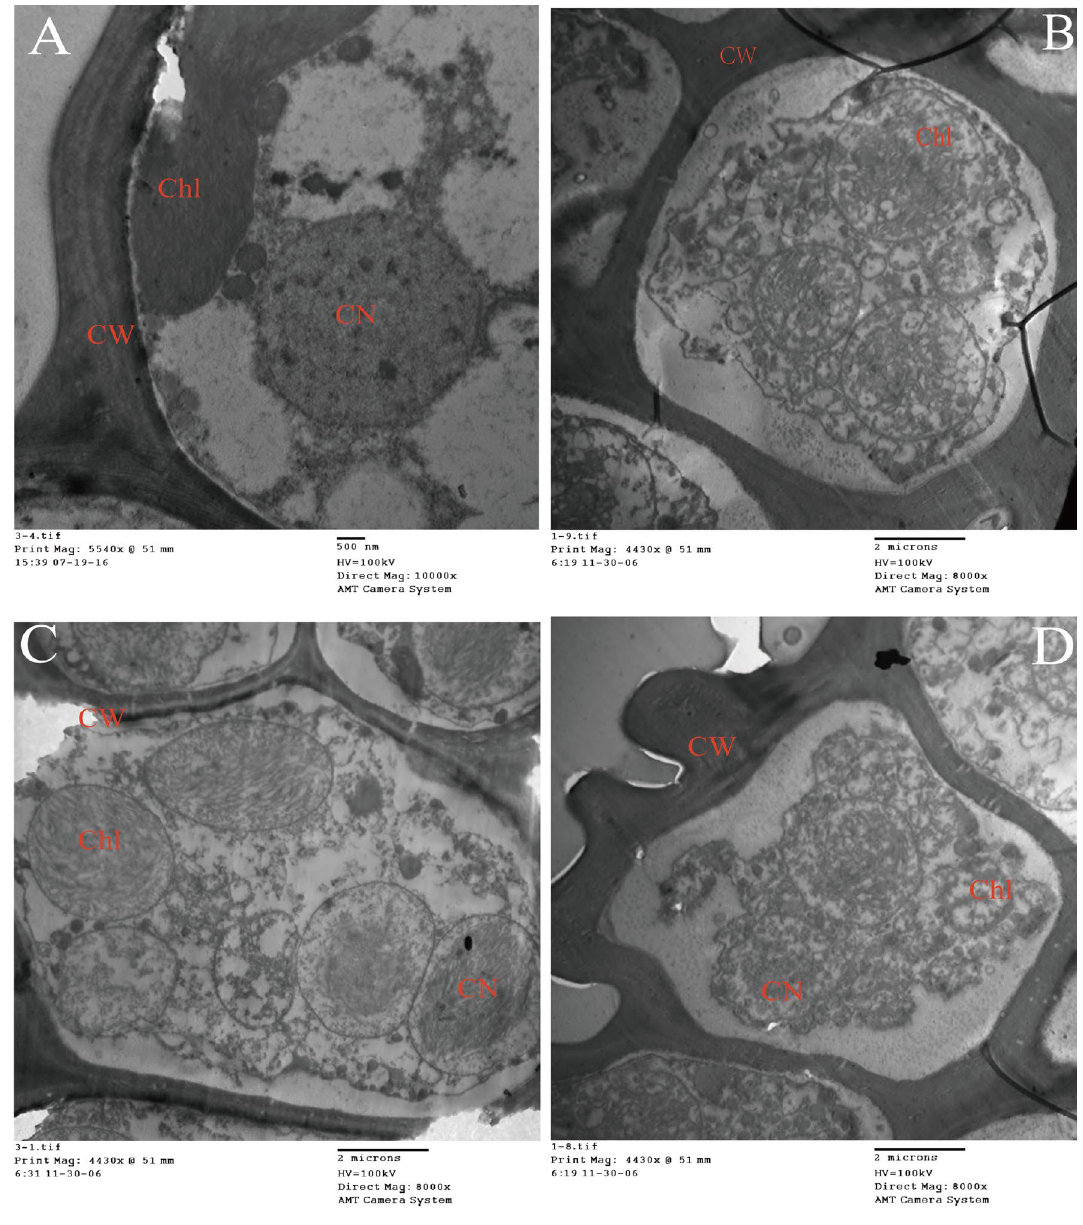
Figure 1. Change in cell ultrastructure in the leaves of S. caninervis along with Hg stress concentration by measured using transmission electron microscopy (TEM). ( A ) control; ( B ) 20 µM Hg concentration; ( C ) 30 µM Hg concentration; ( D ) 50 µM Hg concentration. Chl chloroplast, CN cell nucleus, CW cell wall, CM cell membrane, SG starch